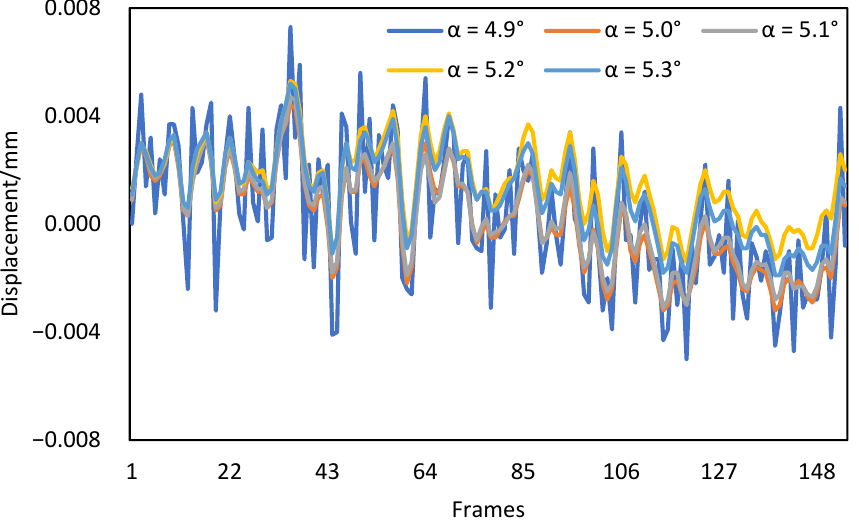
Figure 11. The corrected displacements of target 165 obtained with different tilt angles.